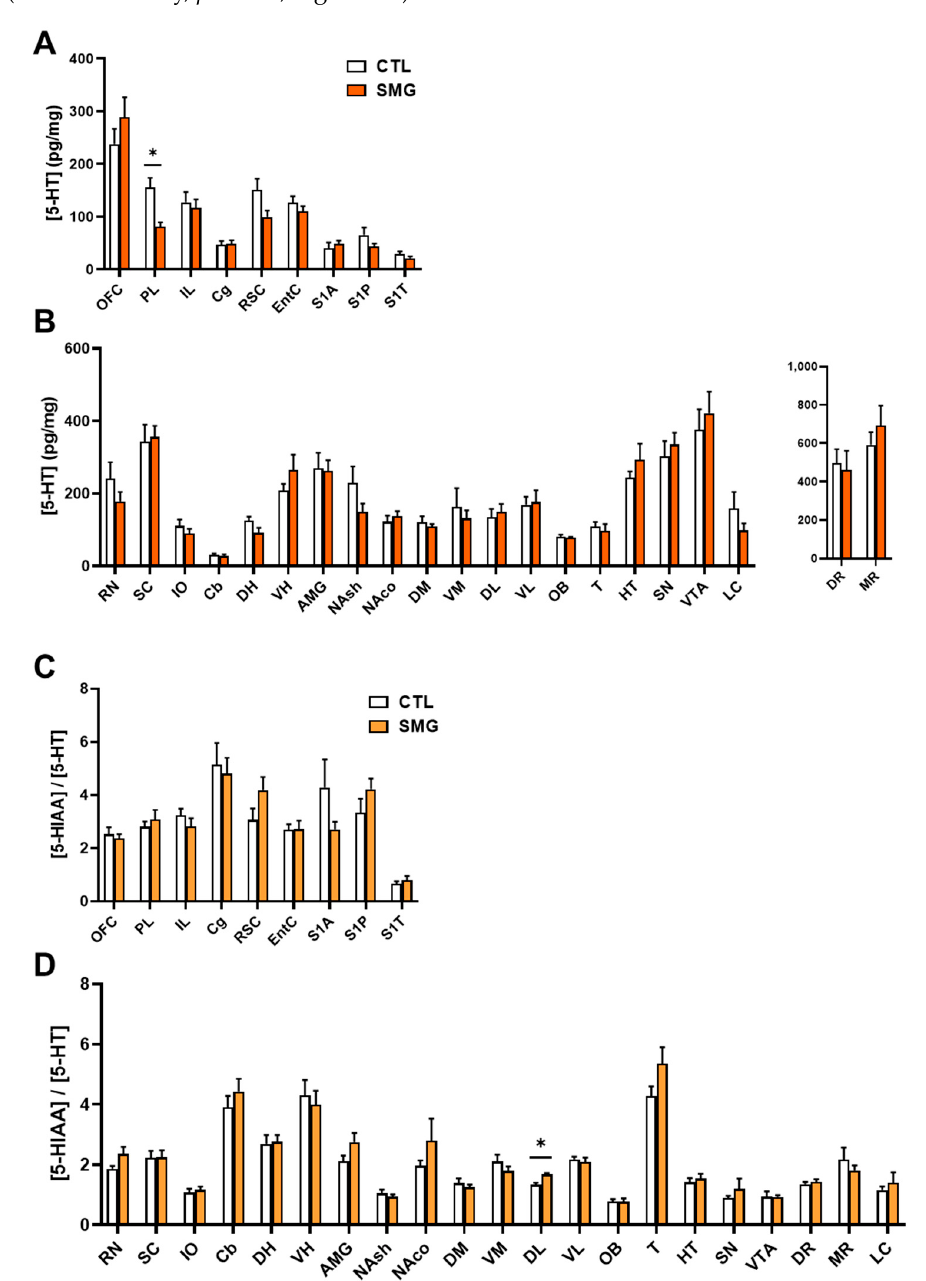
Figure 5. Effect of the SMG on the neurochemistry of the 5-HT system in the brain. 5-HT concentration in pg/mg of tissue for each group is shown in sampled cortical ( A ) and sub-cortical ( B ) brain regions. The ratio of the 5-HIAA concentration relative to 5-HT concentration is reported in sampled cortical ( C ) and sub-cortical ( D ) regions. All data are presented as mean ± sem ( n = 12 rats/group). * p < 0.05, significant difference between SMG and CTL group (Mann–Whitney test).